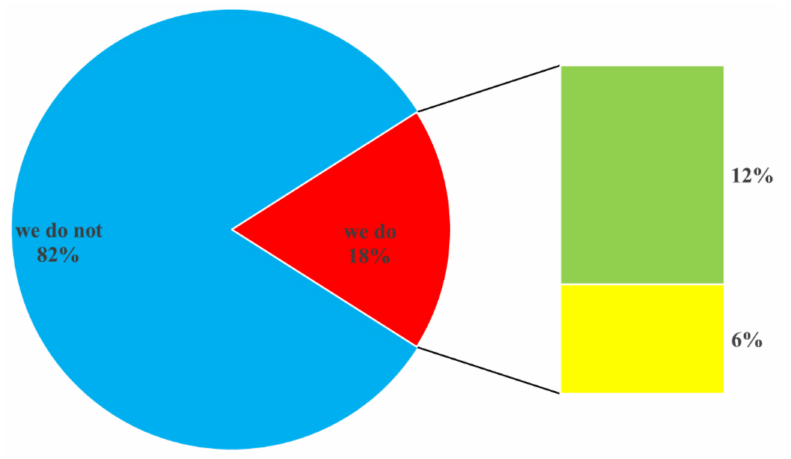
Figure 6. The scale of use of catalysts for fuels and the solutions for improving combustion among the respondents, as indicated by answers to the question: “Do you use any catalysts for fuel combustion? If you do, what is the purpose of its